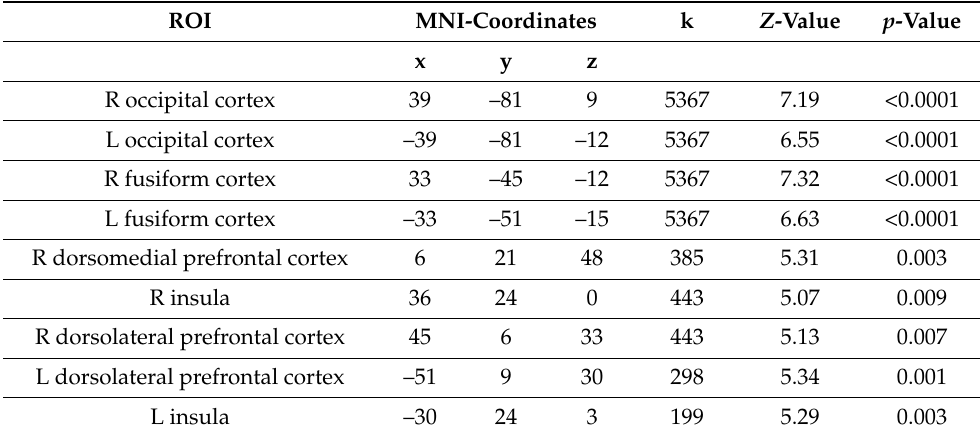
Table 2. Main effect of food pictures versus baseline across